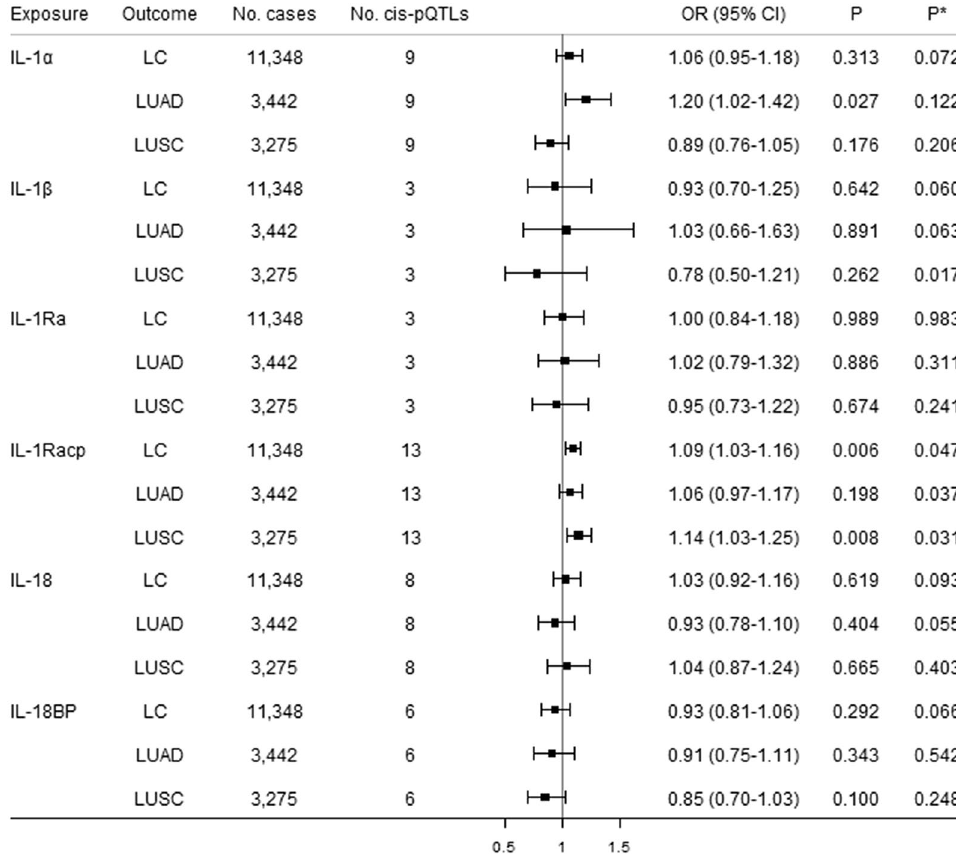
Figure 1. Causal estimates of genetically predicted IL-1α, IL-1β, IL-1Ra, IL-1Racp, IL-18, and IL-18BP with lung cancer (LC) and its subtypes [lung adenocarcinoma (LUAD) and squamous cell lung cancer (LUSC)] using univariable MR analyses. Cis -pQTLs is cis protein quantitative loci. P * indicates the Q-statistic